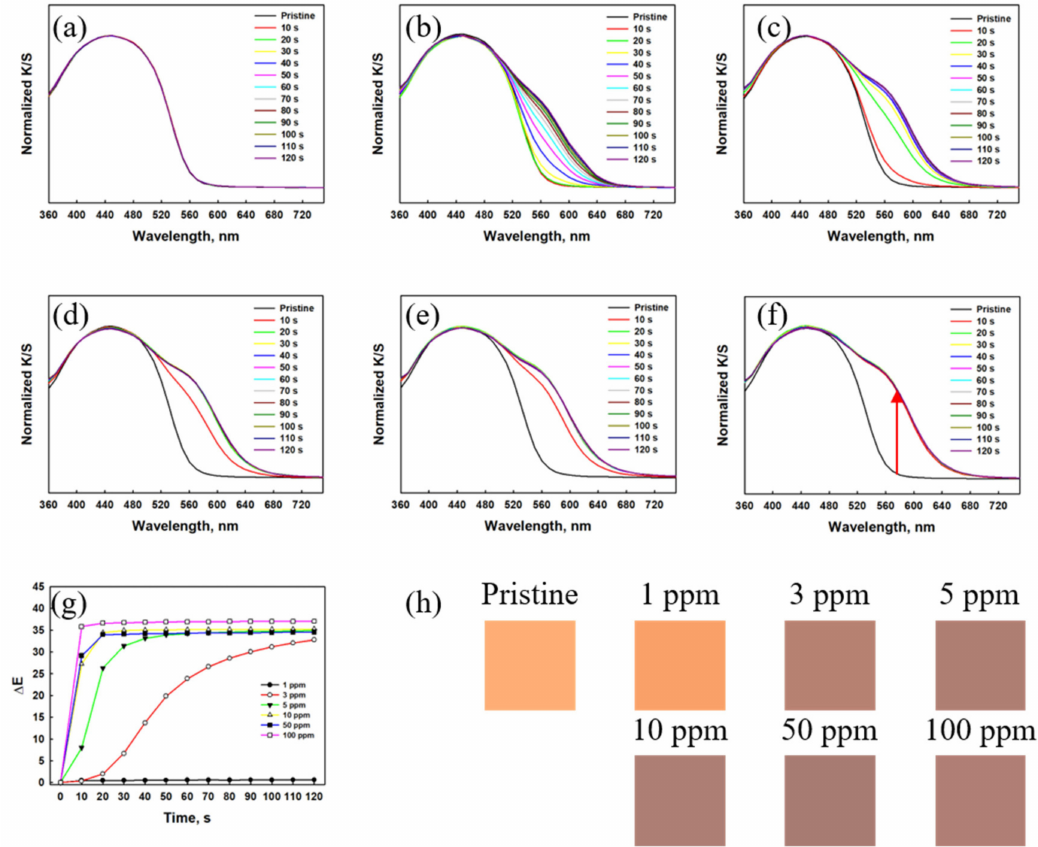
Figure 7. Color data for the textile sensor based on mixed dyes (Dye 3 / RhYK) after exposure to various concentrations of gaseous HCl: ( a – f ) Time-dependent K / S values upon exposure to 1, 3, 5, 10, 50, and 100 ppm HCl; ( g ) Time-dependent color di ff erences; ( h ) Color